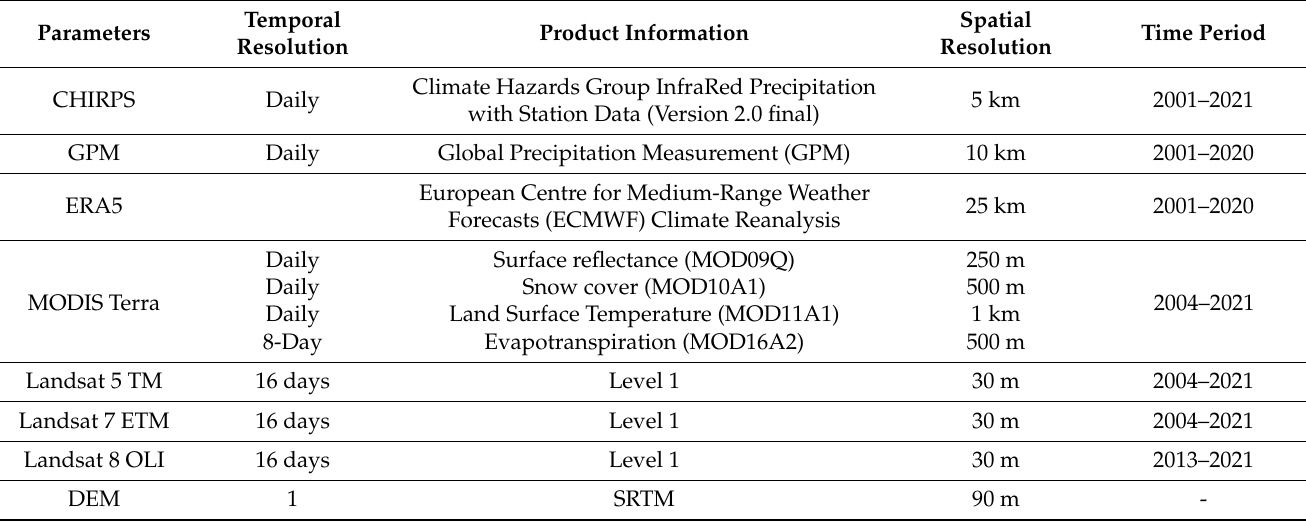
Table 3. Specifications of used datasets of satellite imagery available in Google Earth